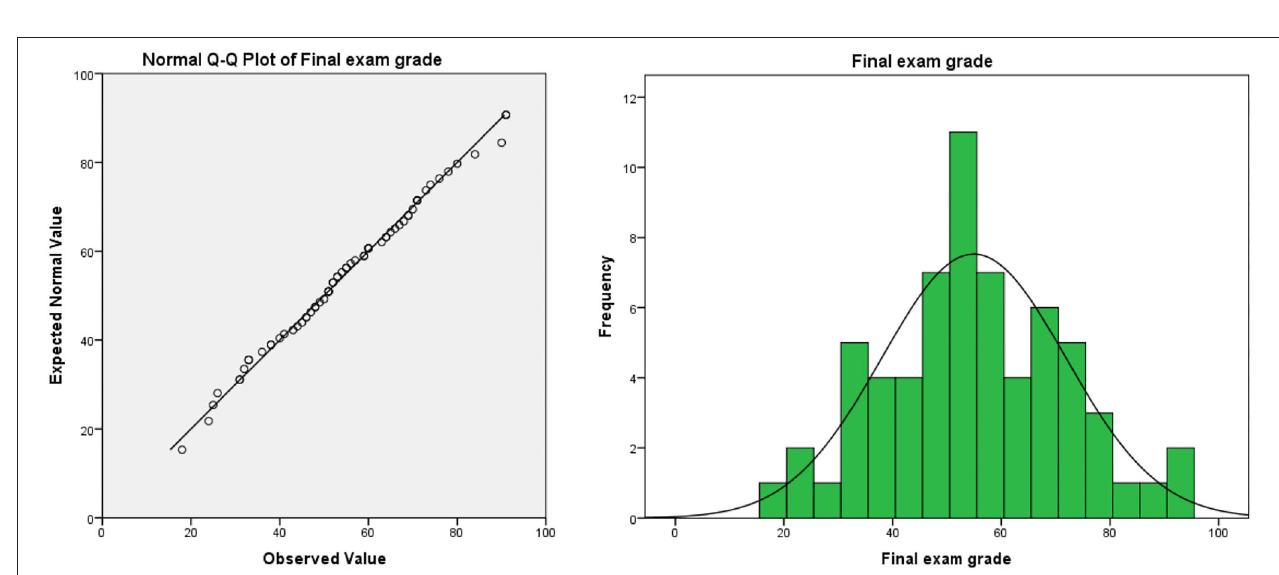
FIGURE 6 | Final exam grade of an online-offline teaching model.